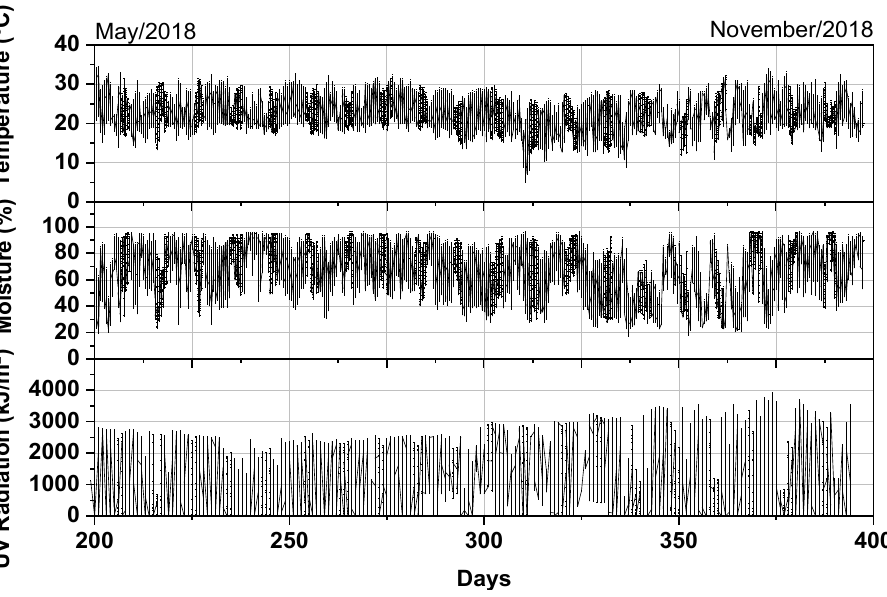
Figure 11. Weather data for the weather exposure. Source: